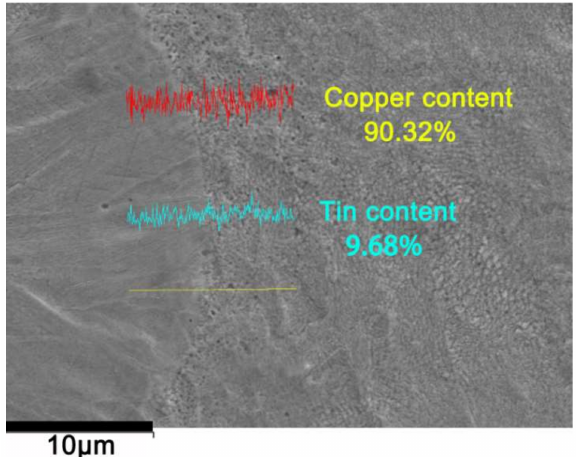
Figure 5. Component analysis at a laser energy density of 220 J/mm 2